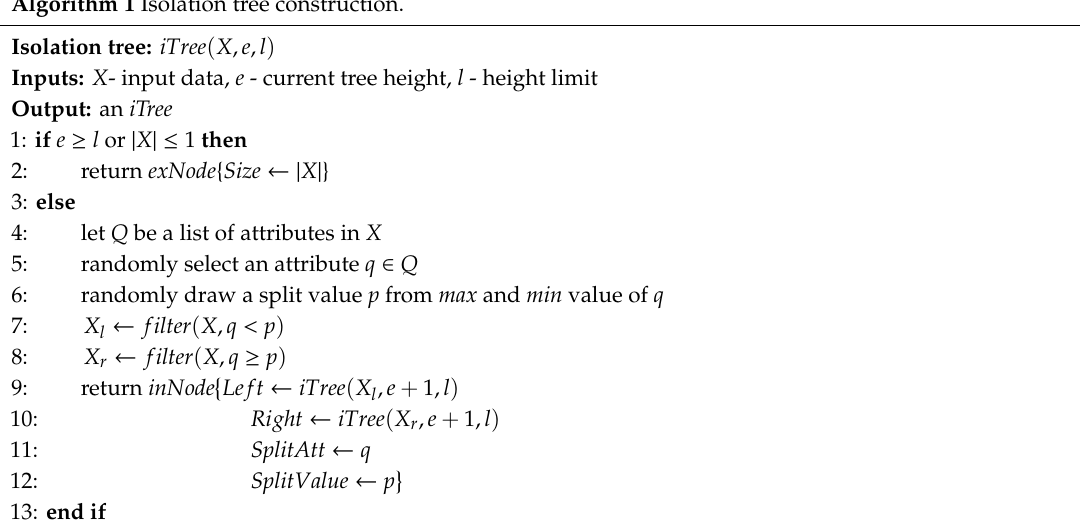
Algorithm 1 Isolation tree